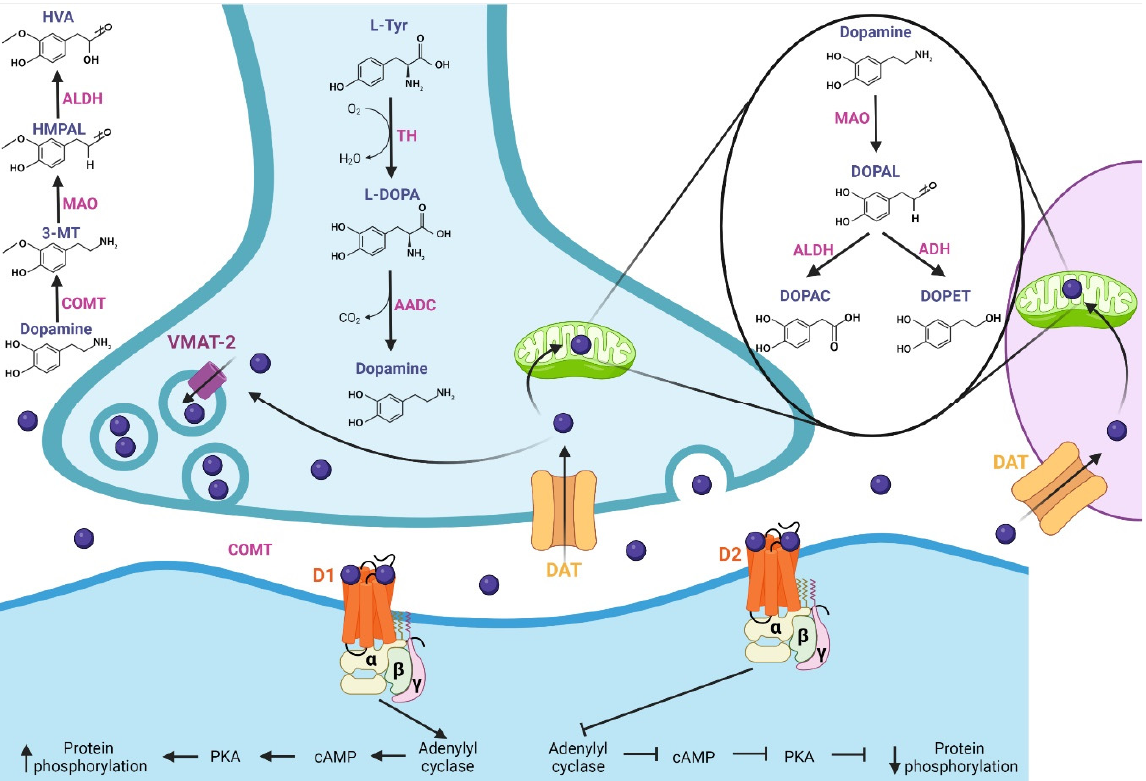
Figure 1. Synthesis, release, catabolism, and postsynaptic action of dopamine. Synthesis: The TH